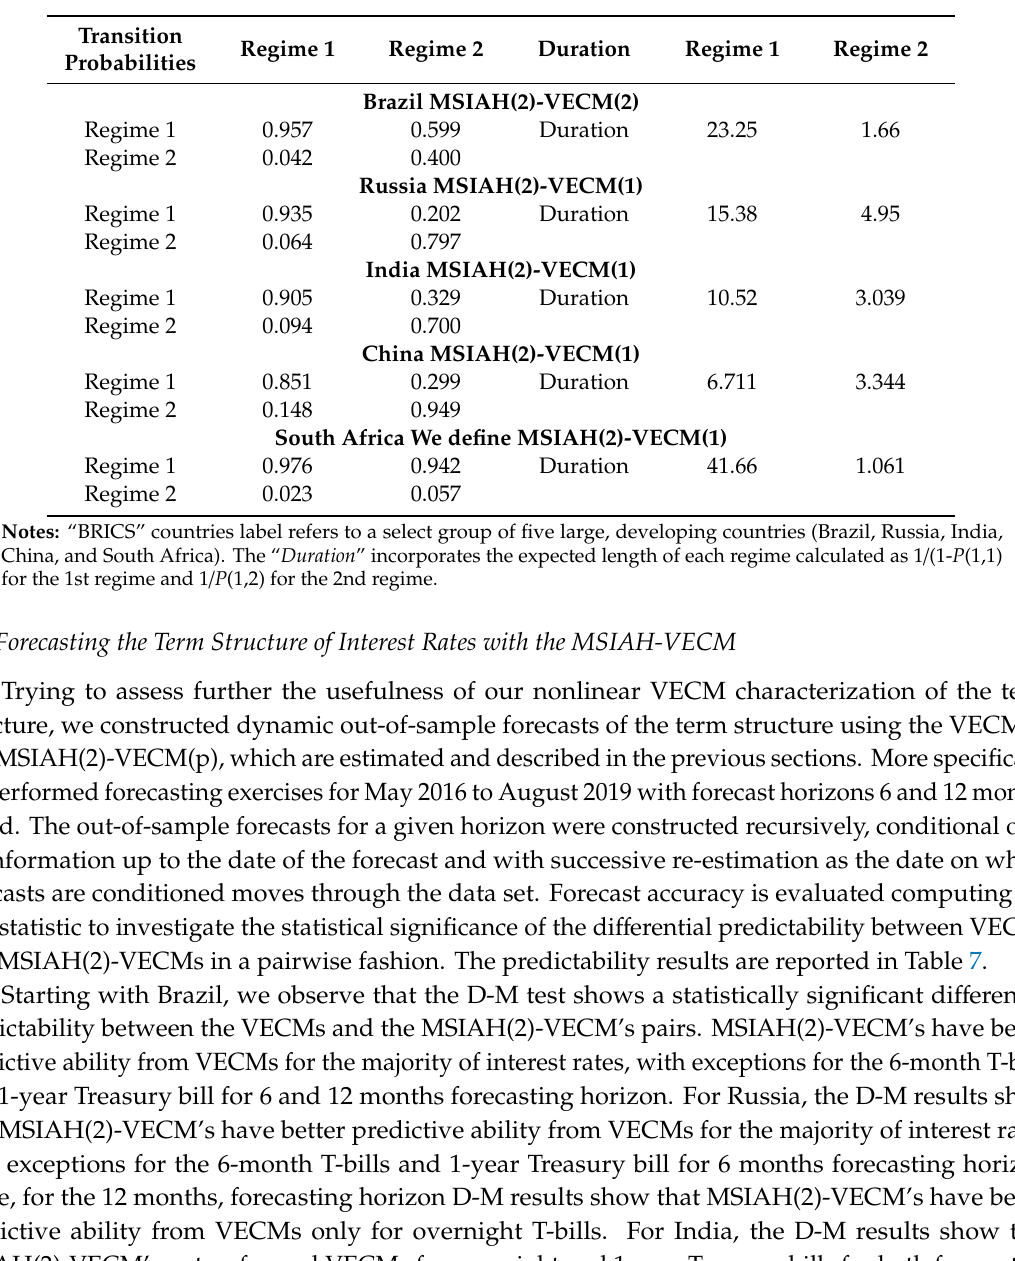
Table 6. Markov-switching-intercept-autoregressive-heteroskedastic (MSIAH)(2)-VECM(p) results for